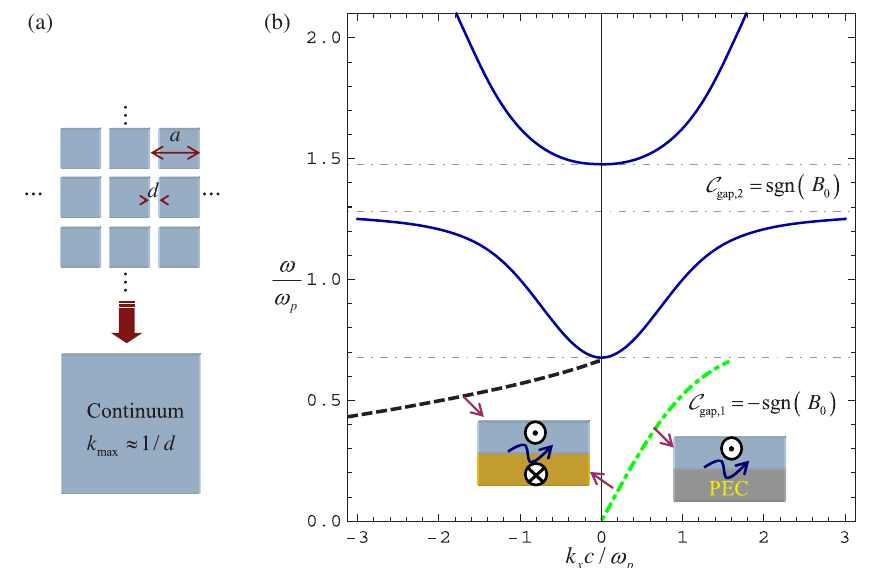
FIG. 3. (a) Geometry of a two-dimensional photonic crystal formed by square-shaped gyrotropic-material inclusions organized in a square lattice. For sufficiently low frequencies the photonic crystal may be regarded as a continuum with a spatial frequency cutoff k (b) Band structure of material (solid blue lines) and dispersion of the edge states in the first band gap for (i) a gyrotropic-PEC interface (dot-dashed green line) and (ii) gyrotropic-gyrotropic interface with the materials biased with magnetic fields oriented in opposite directions (dot-dashed green line and dashed black line). The band structure, the edge-state dispersions, and the gap Chern numbers (indicated in the insets) are found using the continuum